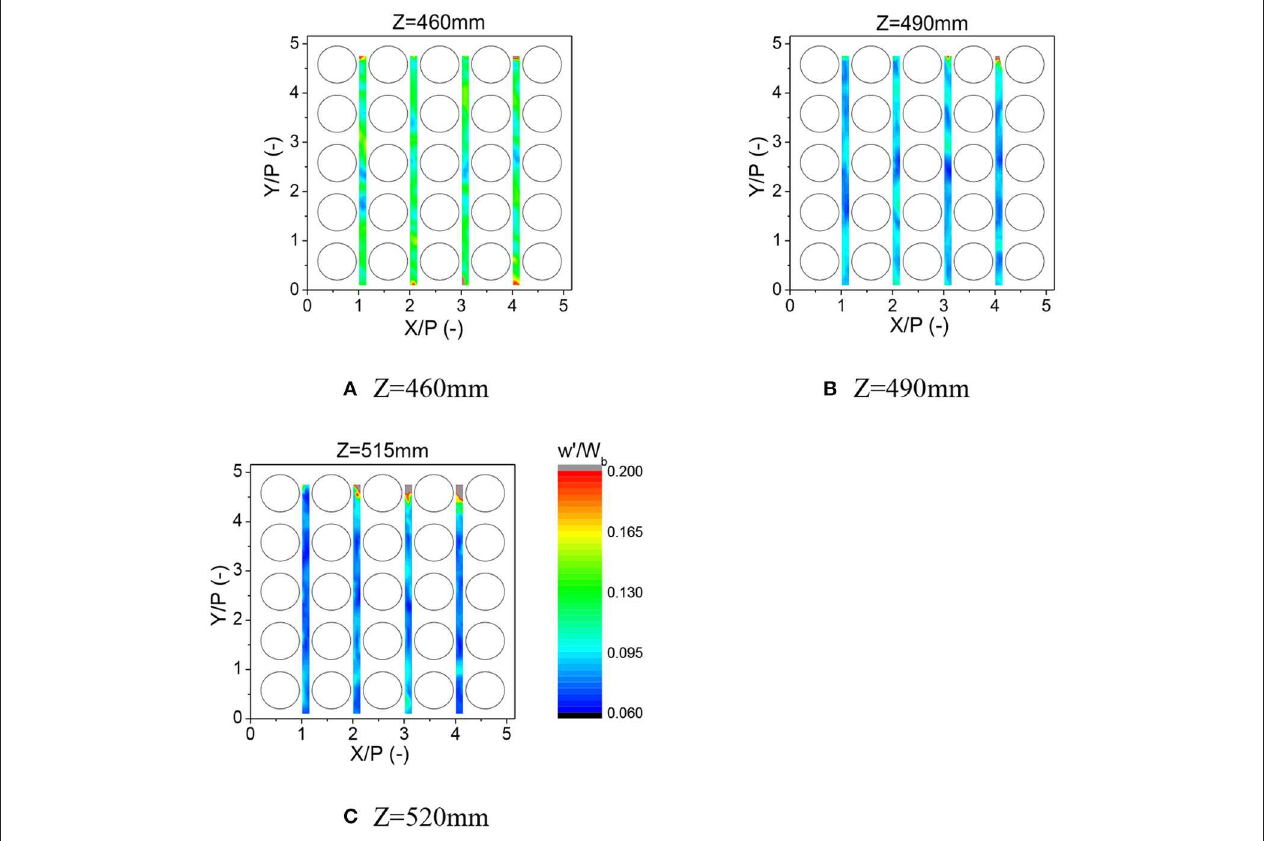
FIGURE 7 | Evolution of axial root mean square velocity distribution downstream of the mixing-vane spacer grid ( Re (C) Z =